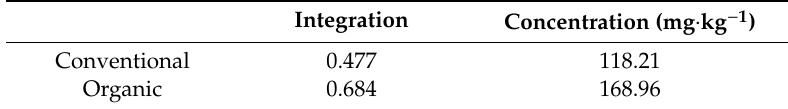
Table 3. Concentration of oleocanthal (OLC) measured by qNMR in EVOOs of Hojiblanca variety.